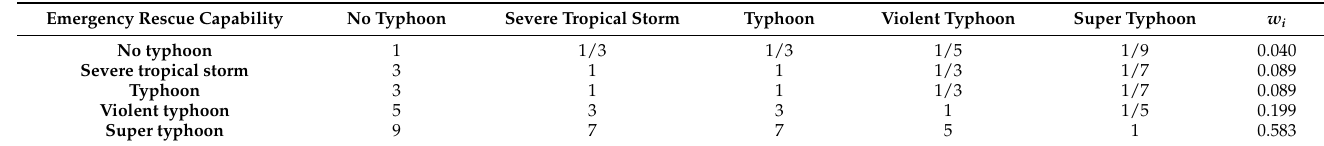
Table 9. Important assessment matrix of emergency rescue capability under different typhoon